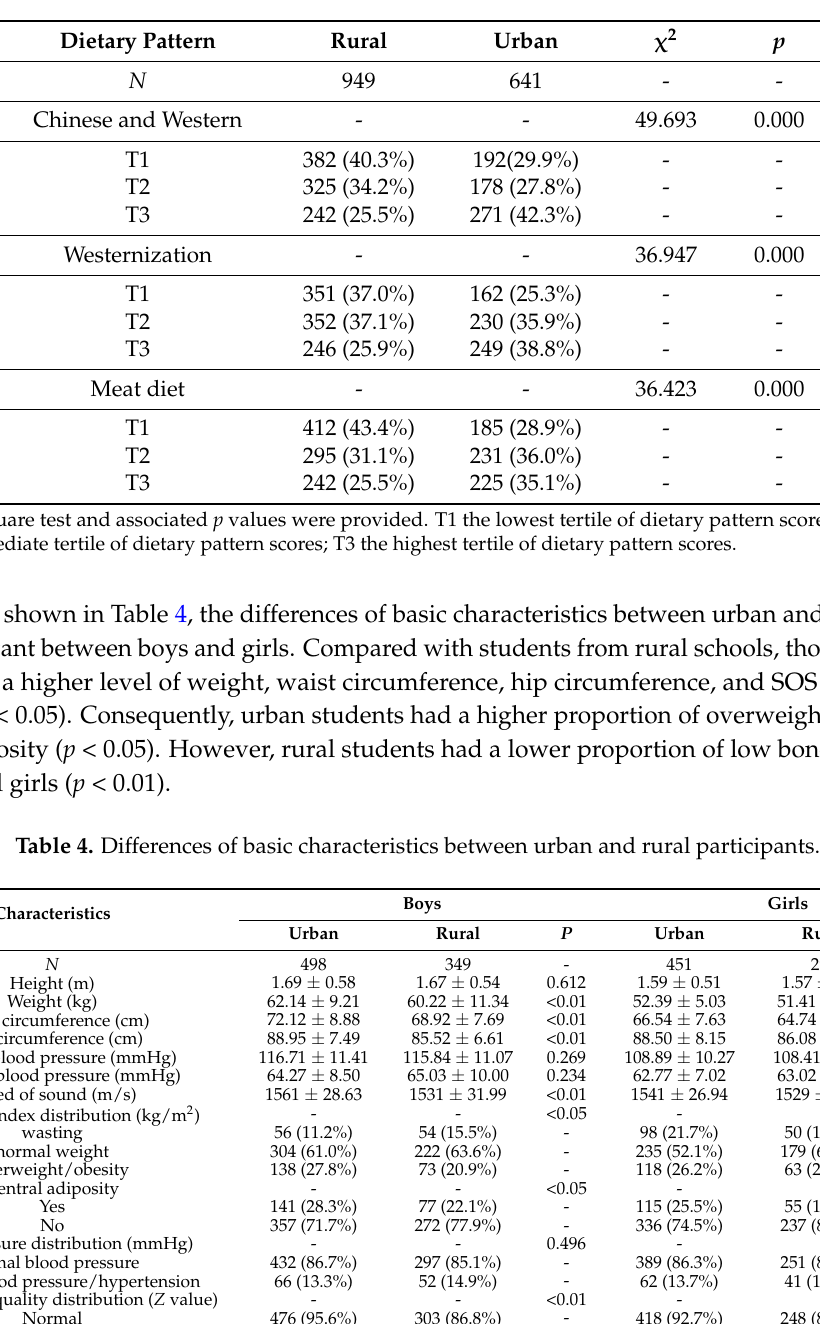
Table 3. Rural-urban differences of primary and middle school students across tertiles of major dietary pattern scores.